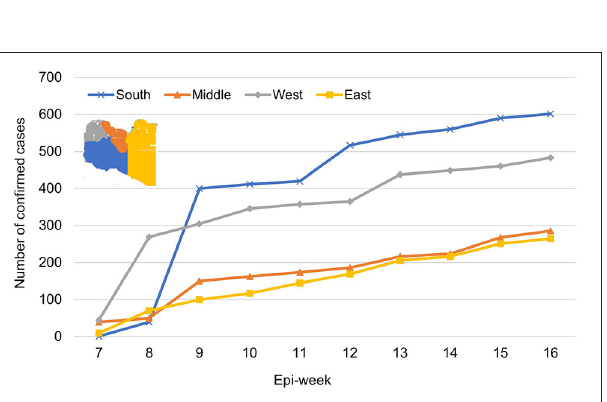
FIGURE 3 | The weekly incidence trends of confirmed cases of COVID-19 in each Libyan region during the study period.